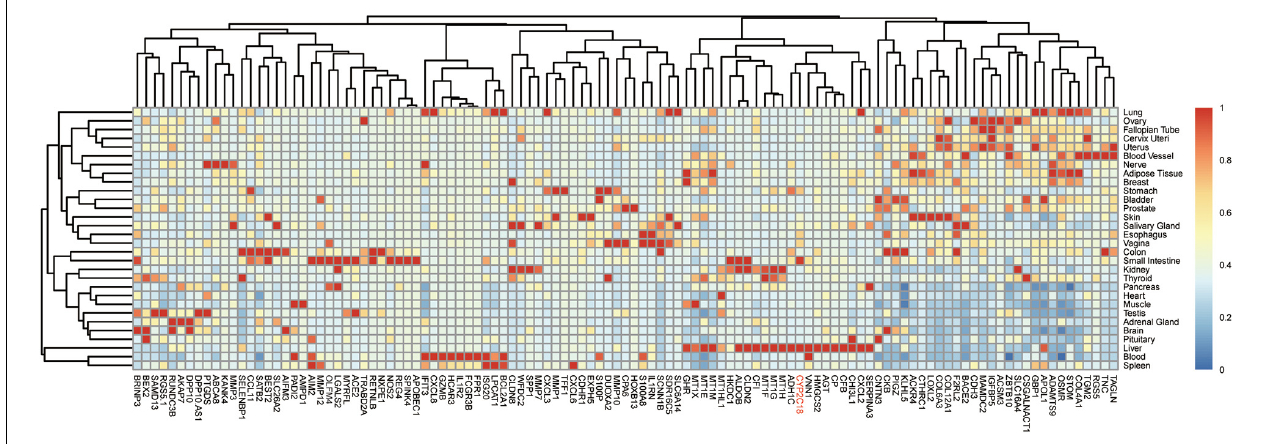
FIGURE 6 | Expression spectrum of the DEGs across different tissues. Normalized expression values across the tissues were shown in the heatmap. Among the identified candidate genes for the pathogenesis of IBD, gene CYP2C18 could be a novel marker for IBD, especially UC and CYP2C18 was labeled in red.